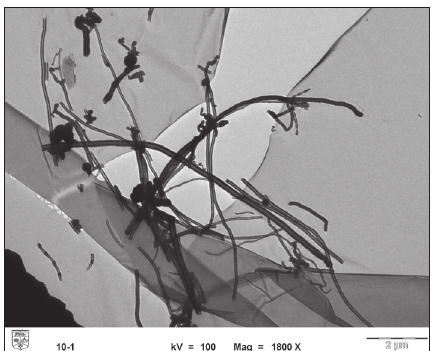
Figure 3: Multiwall carbon nanotube (MWCNTs) particles under TEM.